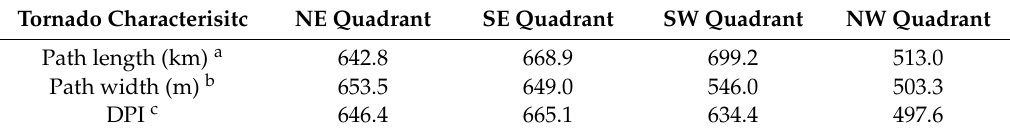
Table 6. Mean ranks used in the Kruskal-Wallis tests for the northeast (NE), southeast (SE), southwest (SW), and northwest (NW) quadrants. Results of the Kruskal-Wallis tests are located below the table. Post-hoc pairwise comparisons indicate that, for all three variables, the mean ranks of the NE and SE quadrants are significantly greater than the mean ranks of the NW